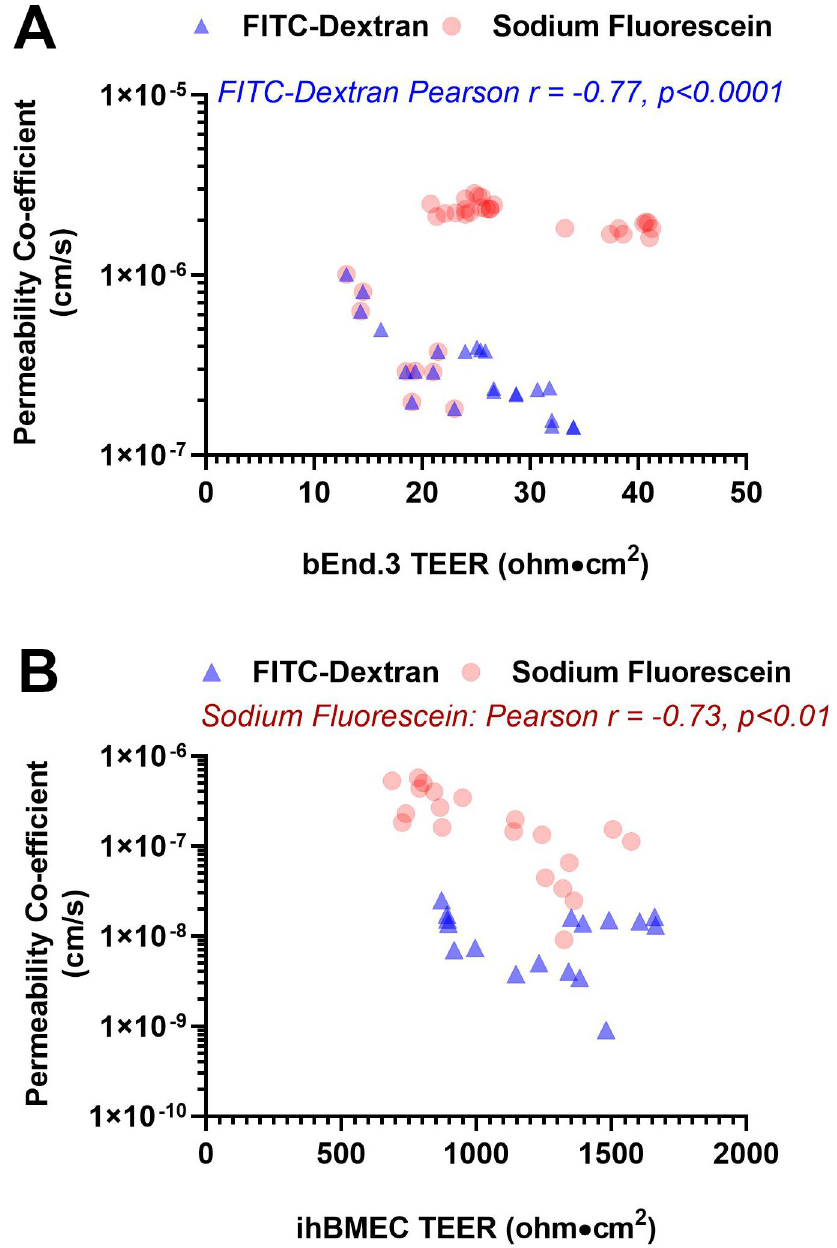
Fig 2. Correlation between TEER measurements and tracer permeability across the bEnd.3 and ihBMEC monolayer. A significant inverse correlation was observed between FITC-dextran and TEER using the bEnd.3 cells ( Pearson r = -0.77, p < 0.0001) ( A ), and between sodium fluorescein and TEER while using the ihBMECs ( Pearson r = -0.73, p < 0.01) ( B ). attachment and engulfment of aged red blood cells (tBHP-treated red blood cells) and not PBS-treated control red blood cells (Fig 4E). A maximum projection confocal image of H&E- stained slides shows autofluorescent ihBMECs and tBHP-treated red blood cells (Fig 4F top panel). An orthogonal view of the confocal image clearly shows the attachment and internali- zation of aged red blood cells by the ihBMECs (Fig 4F bottom panel).